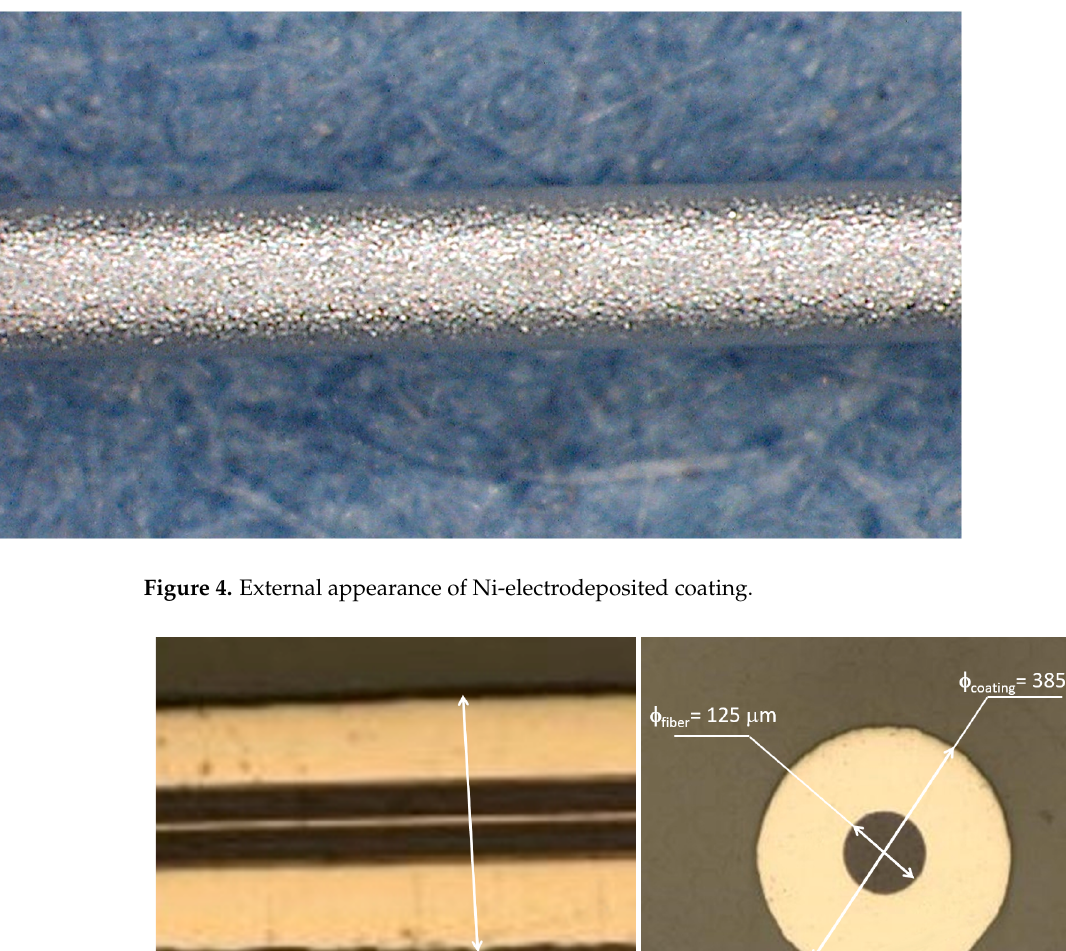
Figure 5. The appearance of the Ni-coated fiber at the ( a ) longitudinal and ( b ) cross section. The figures show the diameter of the optical fiber (125 mm) and the diameter of the coating (385 mm); the thickness of the coating (about 130 mm) can be deduced from these dimensions.